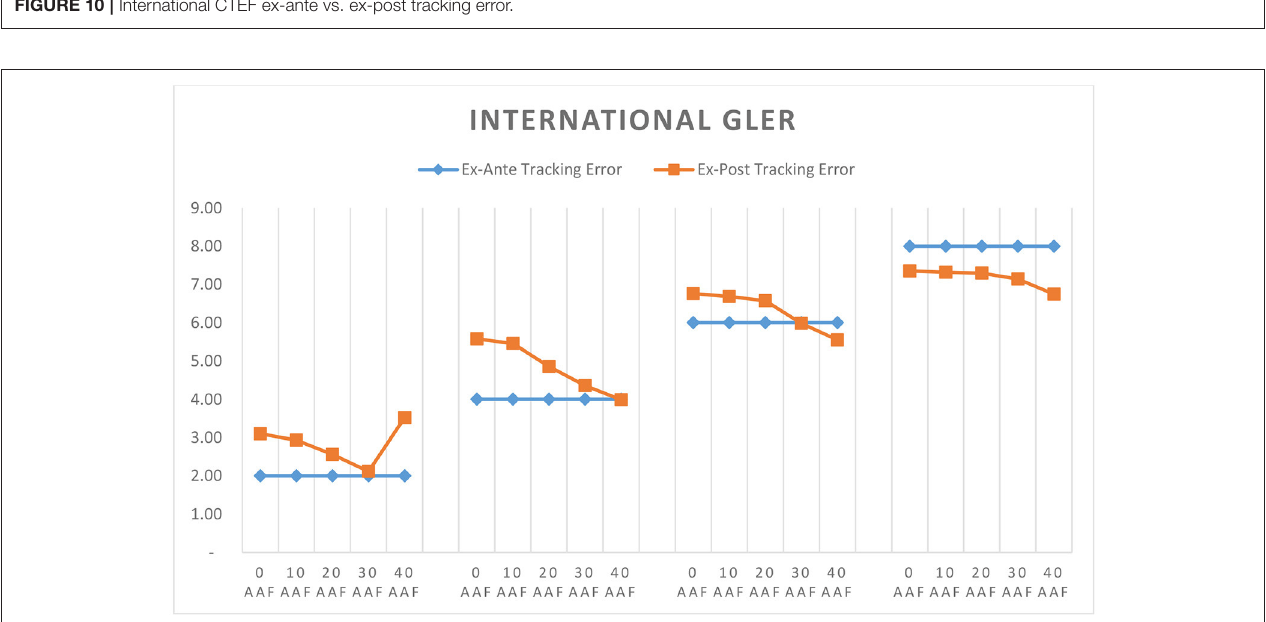
FIGURE 11 | International GLER ex-ante vs. ex-post tracking error.